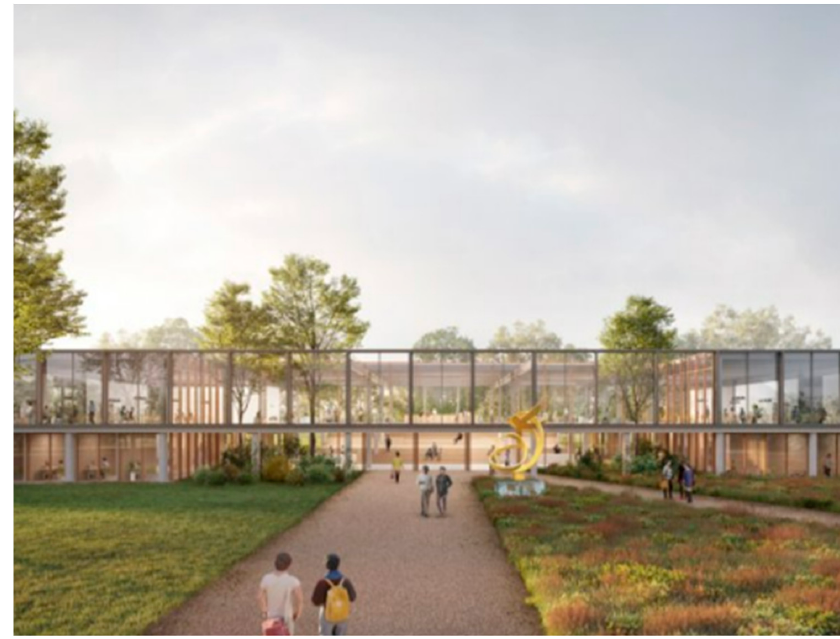
Figure 2. Preliminary design of the new ITC building [44].